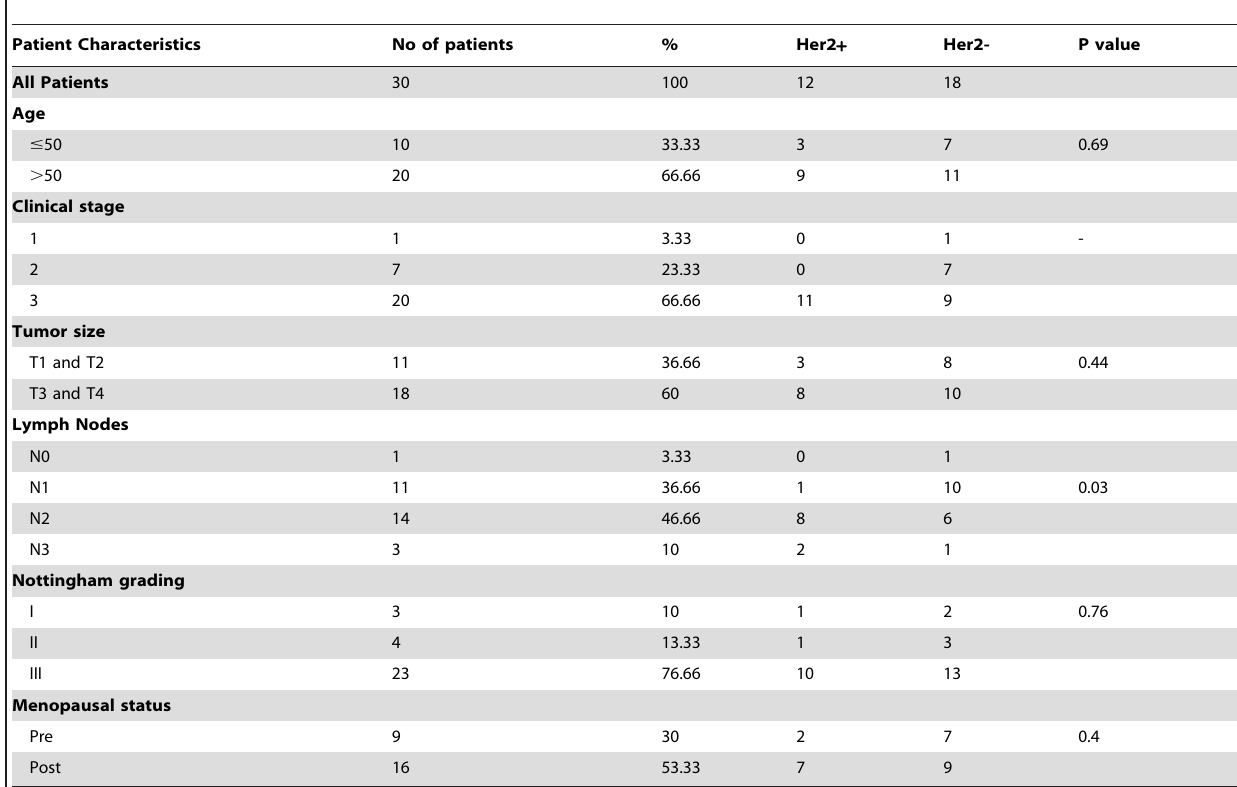
Table 4. Her2 expression and clinicopathological characteristics.